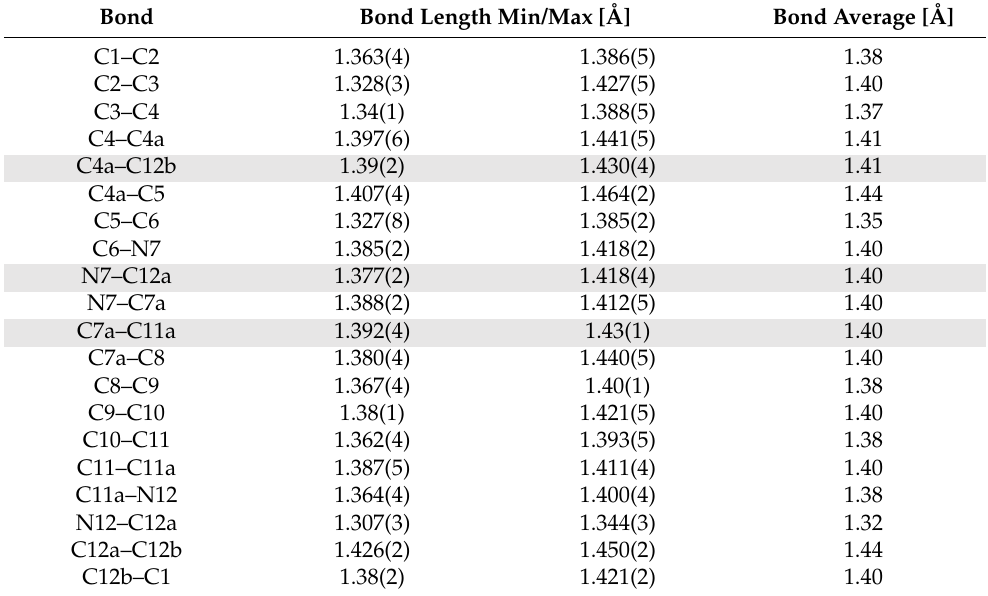
Table 1. Bond length range and averages [Å] from crystallographic data (for numbering see Figure 1). Bridging internal bonds are